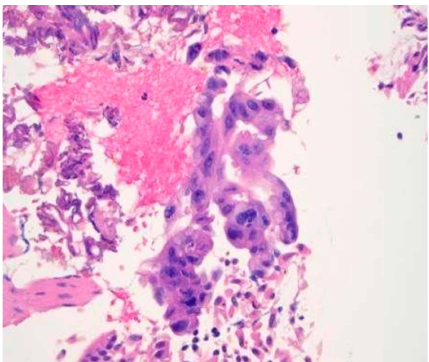
Figure 5: Biliary stricture adenocarcinoma at 400X. Small cluster of atypical glandular cells present, which is highly suspicious for adenocarcinoma. The cytopathology report from brushings showed